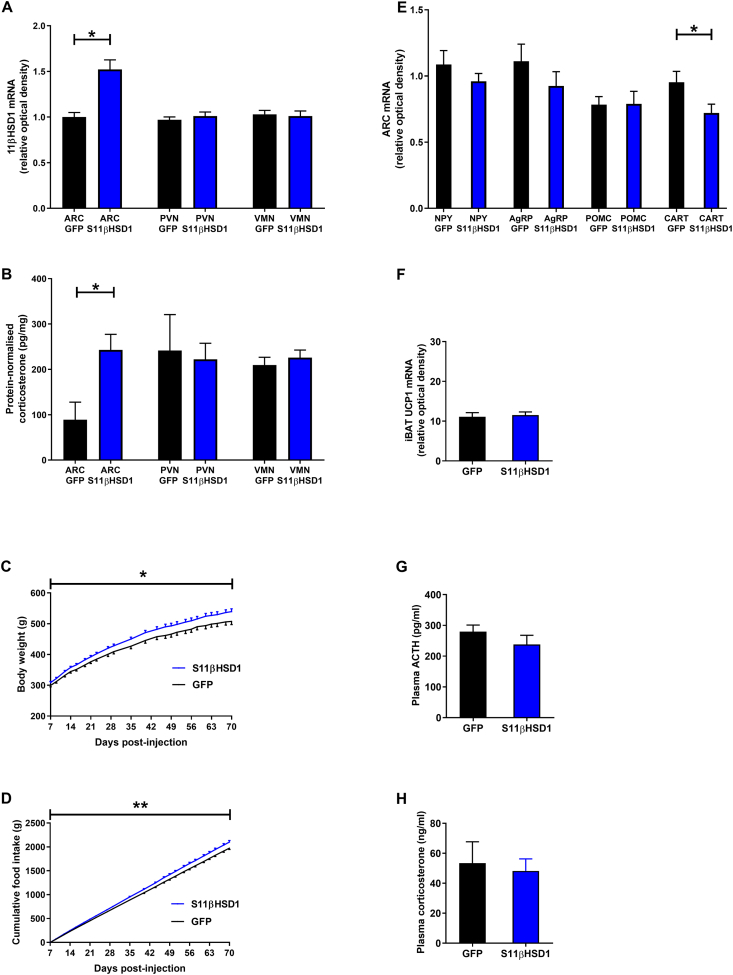
Increased corticosterone in the arcuate nucleus of adult male rats is associated with hyperphagia and elevated body weight. A: Bilateral injection of sense 11βHSD1 rAAV (rAAV-S11βHSD1) into the arcuate nucleus (ARC) results in a significant increase in 11βHSD1 mRNA expression within the ARC but does not affect 11βHSD1 expression in the paraventricular nucleus (PVN) or ventromedial nucleus (VMN); GFP: n = 3, S11βHSD1: n = 6; ∗p < 0.05 (Mann–Whitney test). B: Bilateral injection of rAAV-S11βHSD1 into the ARC results in a significant increase in corticosterone levels within the ARC but does not affect corticosterone levels in the PVN and VMN; GFP: n = 3, S11βHSD1: n = 6; ∗p < 0.05 (Mann–Whitney test). C: Elevated ARC corticosterone is associated with higher body weight compared to controls; GFP: n = 11, S11βHSD1: n = 12; ∗p < 0.05 (generalized estimating equation, GEE). D: Elevated ARC corticosterone is associated with higher food intake compared to controls; GFP: n = 11, S11βHSD1: n = 12; ∗∗p < 0.01 (GEE). E: Elevated ARC corticosterone is associated with reduced expression of cocaine- and amphetamine-regulated transcript (CART) in the ARC but does not affect the expression of neuropeptide-Y (NPY), Agouti-related peptide (AgRP) and pro-opiomelanocortin (POMC); GFP: n = 3, S11βHSD1: n = 6; ∗p < 0.05 (Mann–Whitney test). F: Elevated ARC corticosterone does not affect interscapular brown adipose tissue (iBAT) uncoupling protein-1 (UCP1) expression; GFP: n = 11, S11βHSD1: n = 12 (unpaired t-test). G: Elevated ARC corticosterone does not affect plasma adenocorticotrophic hormone (ACTH) levels; GFP: n = 11, S11βHSD1: n = 12 (unpaired t-test). H: Elevated ARC corticosterone does not affect plasma corticosterone levels; (GFP: n = 11, S11βHSD1: n = 12 (unpaired t-test).